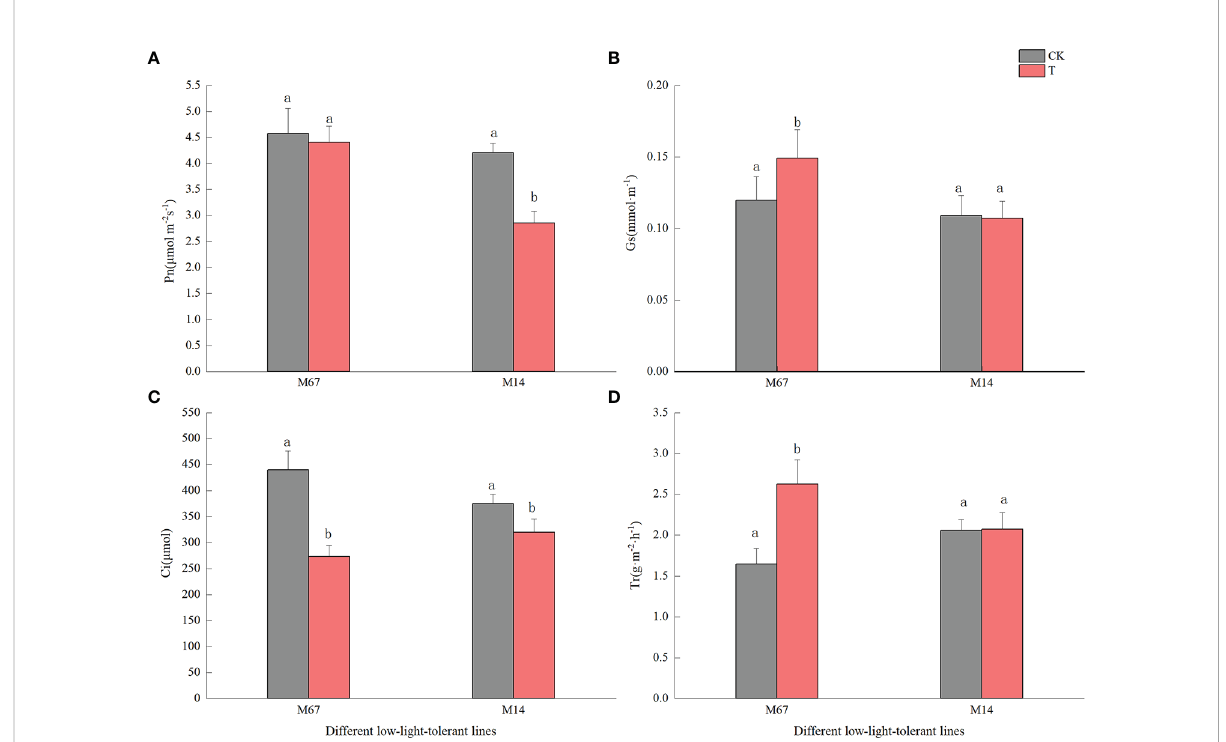
FIGURE 3 Effects on leaf photosynthetic rate of low-light in different cucumber lines. (A) Pn, (B) Gs, (C) Ci and (D) Tr of leaf under control and low-light stress in different cucumber lines. Lowercase letters a and b after the value represent statistically signi fi cant differences (p < 0.05) within a variety under different low-light treatments as determined by the least signi fi cant difference test.